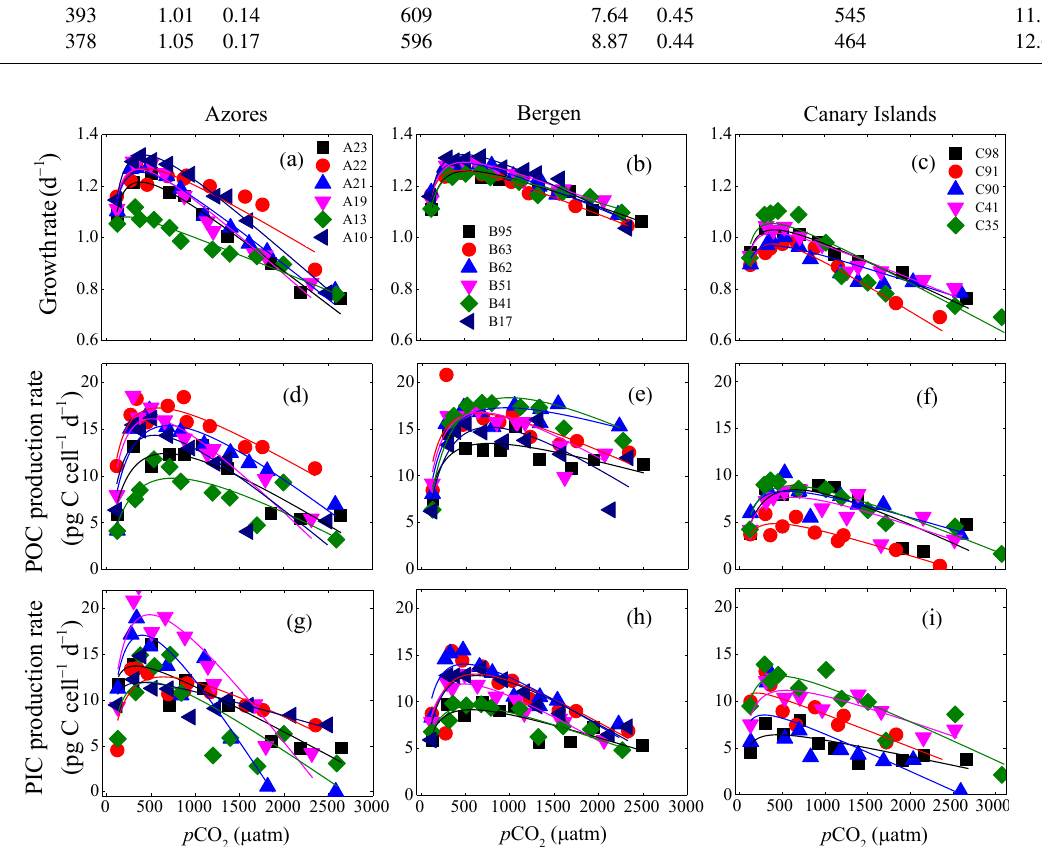
Figure 3. Optimum curve responses of growth, POC, and PIC production rates of individual E. huxleyi strains in the Azores (left), Bergen (center), and Canary Islands (right) populations to a CO 2 range from 115 to 3070µatm. Growth rates of each strain as a function of p CO 2 within the Azores (a) , Bergen (b) , and Canary Islands (c) populations. POC production rates of each strain as a function of p CO 2 within the Azores (d) , Bergen (e) and Canary Islands (f) populations. PIC production rates of each strain as a function of p CO 2 within the Azores (g) , Bergen (h) , and Canary Islands (i) populations. At the strain levels, 115 and 3070µatm was the lowest and highest p CO 2 level,